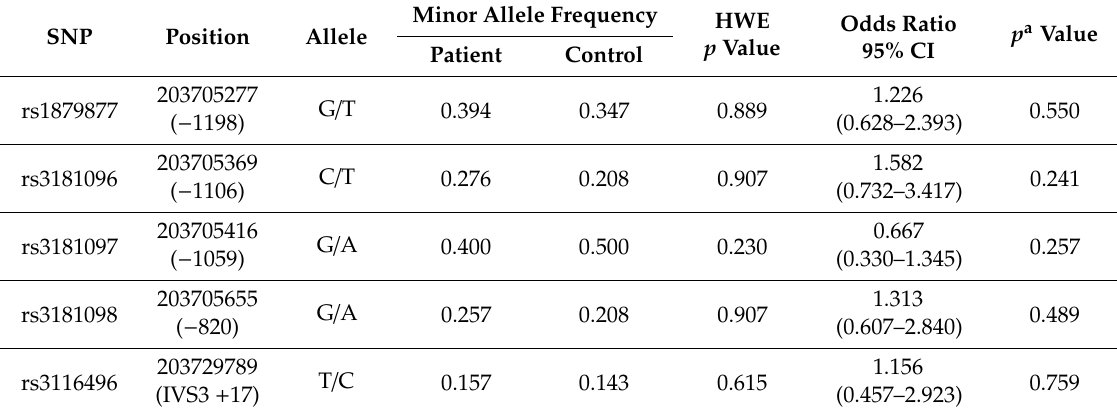
Table 3. Hardy–Weinberg equilibrium (HWE) in control group, allele frequencies and odds ratio for TR in patients and